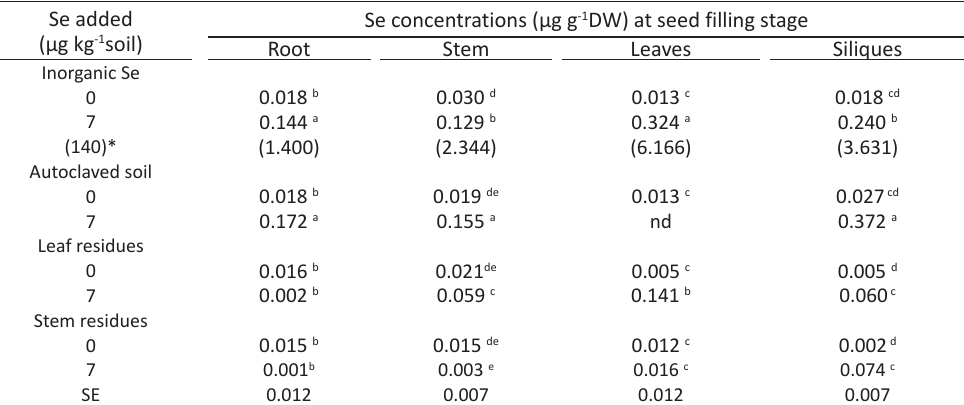
Table 6. Se concentrations (µg g -1 DM) in roots, stems, leaves and the siliques of B. napus L. plants grown in soil treated with inorganic Se (0, 7 and 140 µg kg -1 soil), organic Se (leaf and stem residue, 0 and 7 µg kg -1 soil) and in autoclaved soil with inorganic Se (0 and 7 µg kg -1 soil) at the seed filling stage Se added Se concentrations (µg g -1 DW) at seed filling stage (µg kg -1 soil) Stem Leaves Siliques Inorganic Se